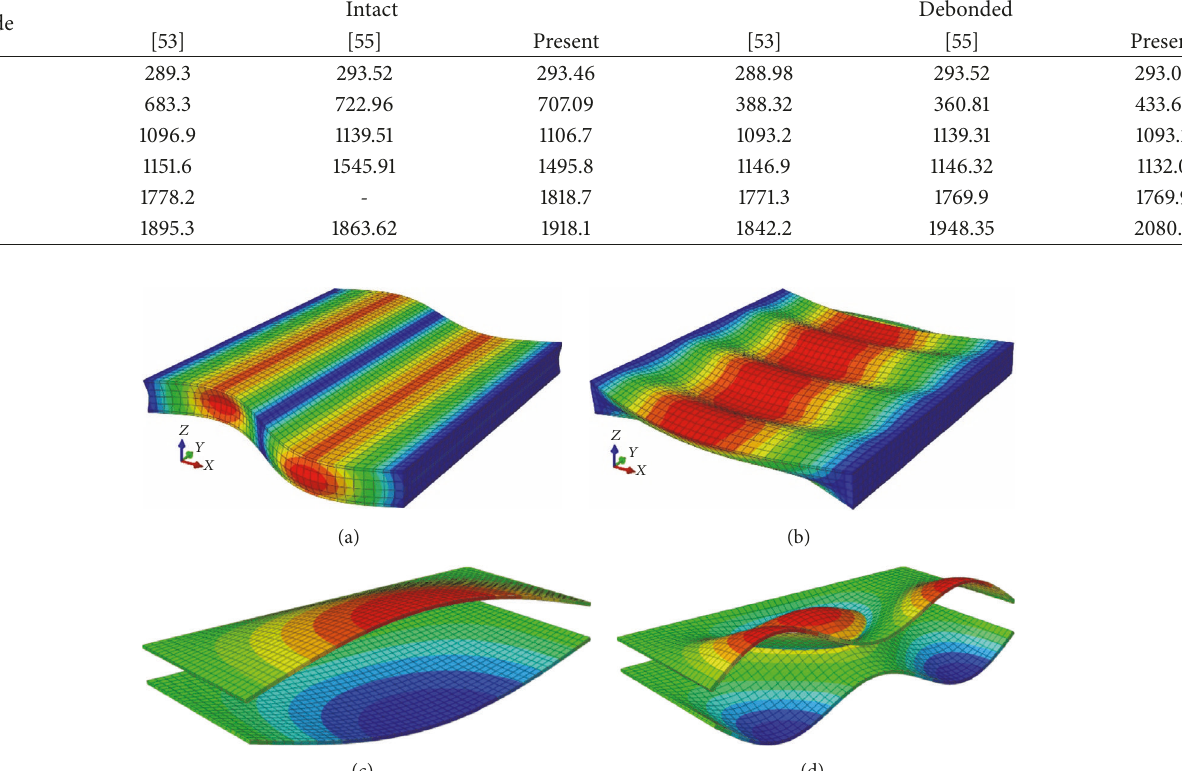
Table 3: Comparison of natural frequencies (Hz) of intact and debonded foam cored sandwich beams.